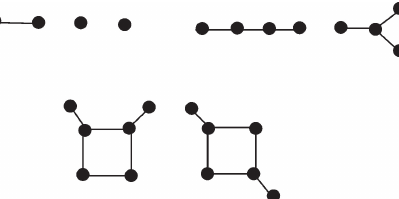
Figure 1: The smallest pairs of graph siblings: disconnected, trees, and cycle-containing. For instance, the characteristic polynomials of the 6-vertex siblings are x 6 − 6 x 4 + 4 x 2 − 1 and x 6 − 6 x 4 + 4 x 2